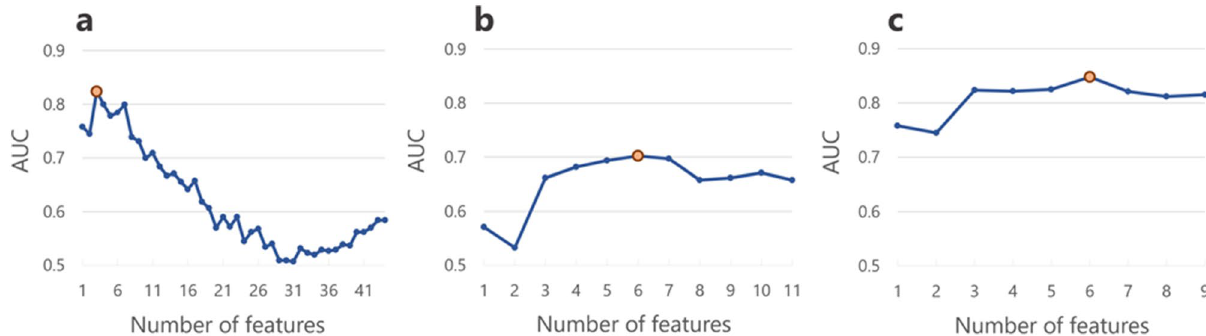
Figure 4 . A comparison of feature subsets for predictive models of pain response using the area under receiver operating characteristic curve. ( a ) Radiomic model; ( b ) clinical model; ( c ) combined model. The optimal number (orange dot) was determined from the highest AUC. The clinical, radiomic and combined feature subsets with the highest AUC contained 6, 3 and 6 features, respectively.